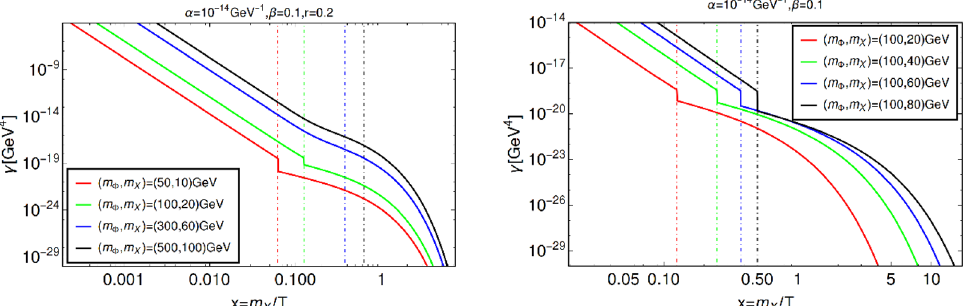
Figure 7 . Total reaction density over the whole range of temperature before and after EWSB taking into account both annihilation and decay before EWSB, but only decay after EWSB. We consider all SM states to be massless before EWSB, while dark sector particles are massive. The dashed-dotted vertical lines correspond to x EW = m X for each choice of DM mass. In the left T EW panel we show densities for different choices of m Φ = { 50 , 100 , 300 , 500 } GeV (in red, green, blue, black, respectively) for fixed r = m X = 0 . 2 , while in the right one they are shown for different m Φ r = { 0 . 2 , 0 . 4 , 0 . 6 , 0 . 8 } (in red, green, blue, black, respectively) for fixed m Φ = 100 GeV . In both cases we choose α = 10 − 14 GeV − 1 , β = 0 . 1